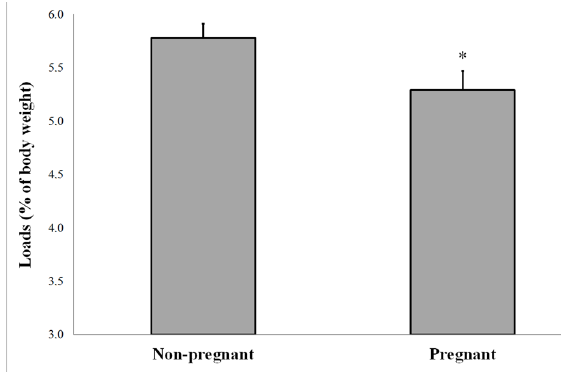
Figure 4 - Comparative analysis of the loads (% of body weight) equivalent to anaerobic threshold of non-pregnant and pregnant rats in all days of experiment, n=5 animals/group. Data presented as mean ± standard error of mean (SEM). *p<0.05 – compared to non-pregnant group (t